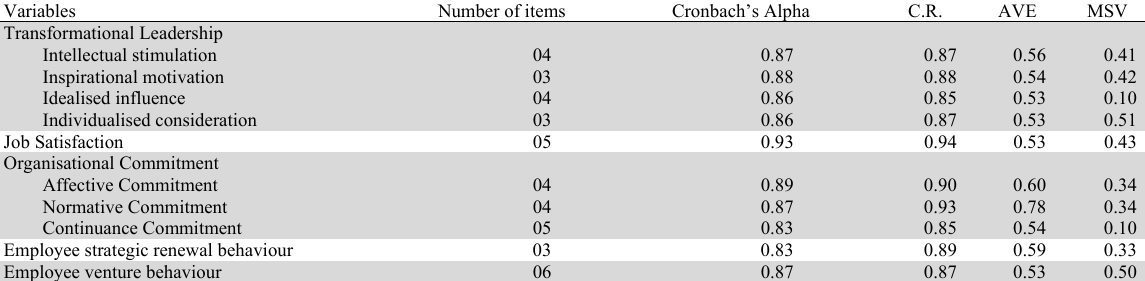
Results of reliability and convergent validity tests Variables Number of items Cronbach’s Alpha C.R. AVE MSV Transformational Leadership Intellectual stimulation Inspirational motivation Idealised influence Individualised consideration